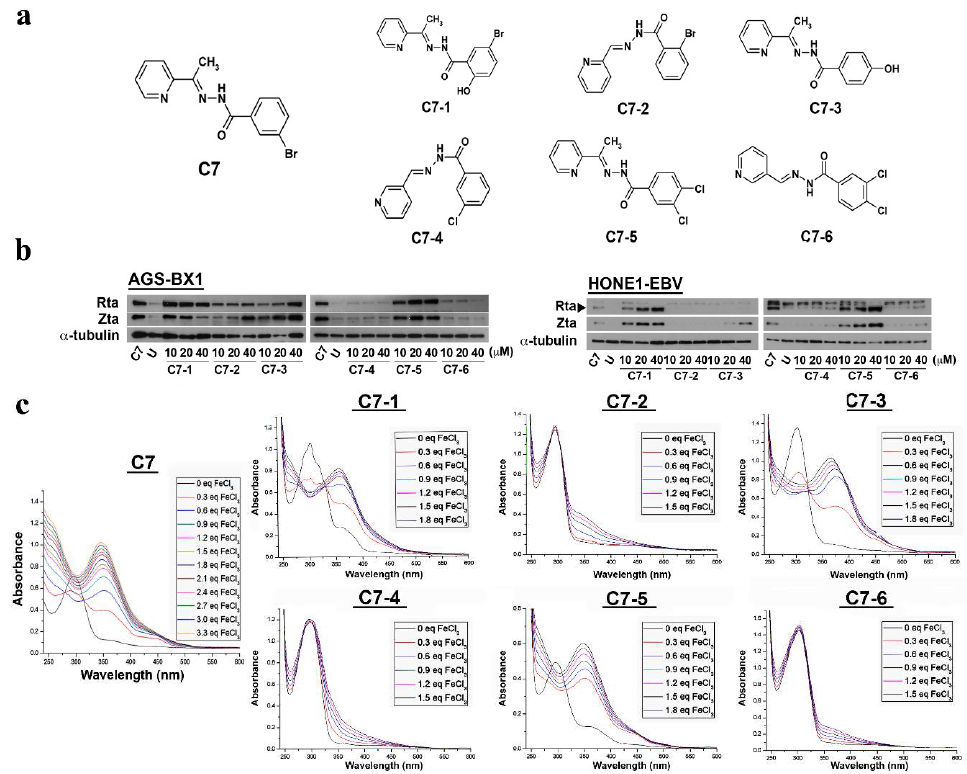
Figure 1. Effects of C7 and its structural analogs on Epstein–Barr virus (EBV) lytic cycle reactivation and the corresponding binding affinity of these compounds to Fe(III). ( a ) The chemical structures of C7 and its analogs obtained from ChemBridge Corp. ( b ) AGS-BX1 and HONE1-EBV cells were either untreated (U) or incubated with the C7 analogs at 10, 20 and 40 μM for 48 h and the expression of IE lytic proteins, Zta and Rta, was detected by Western blotting. Cellular α-tubulin was detected as a loading control. Treatment of AGS-BX1 cells with 10 μM C7 and HONE1-EBV cells with 5 μM C7 were included as positive controls. ( c ) Metal salt FeCl 3 was added to 50 μM of C7 and C7 analogs from C7-1 to C7-6 in methanol in increments of 0.3 equivalents. Absorbance in the UV-Vis was measured after each addition until saturation was reached. Binding between C7/C7 analogs and FeCl 3 was indicated by shift in peaks of the absorbance curve.